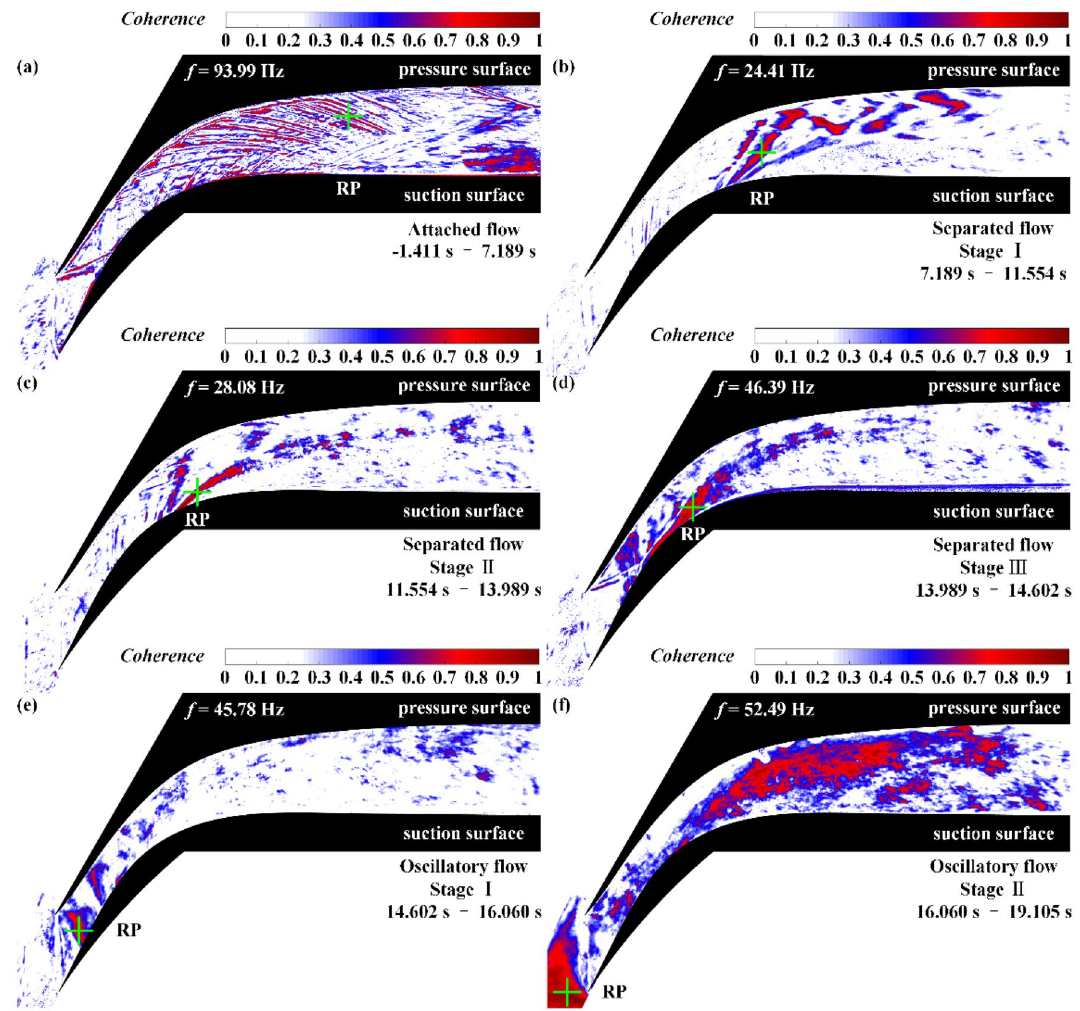
Figure 12. Coherence contours of the flow field during ( a ) attached flow, ( b ) stage I of separated flow, ( c ) stage II of separated flow, ( d ) stage III of separated flow, ( e ) stage I of oscillatory flow, and ( f ) stage II of oscillatory flow. The symbol + represents the reference point